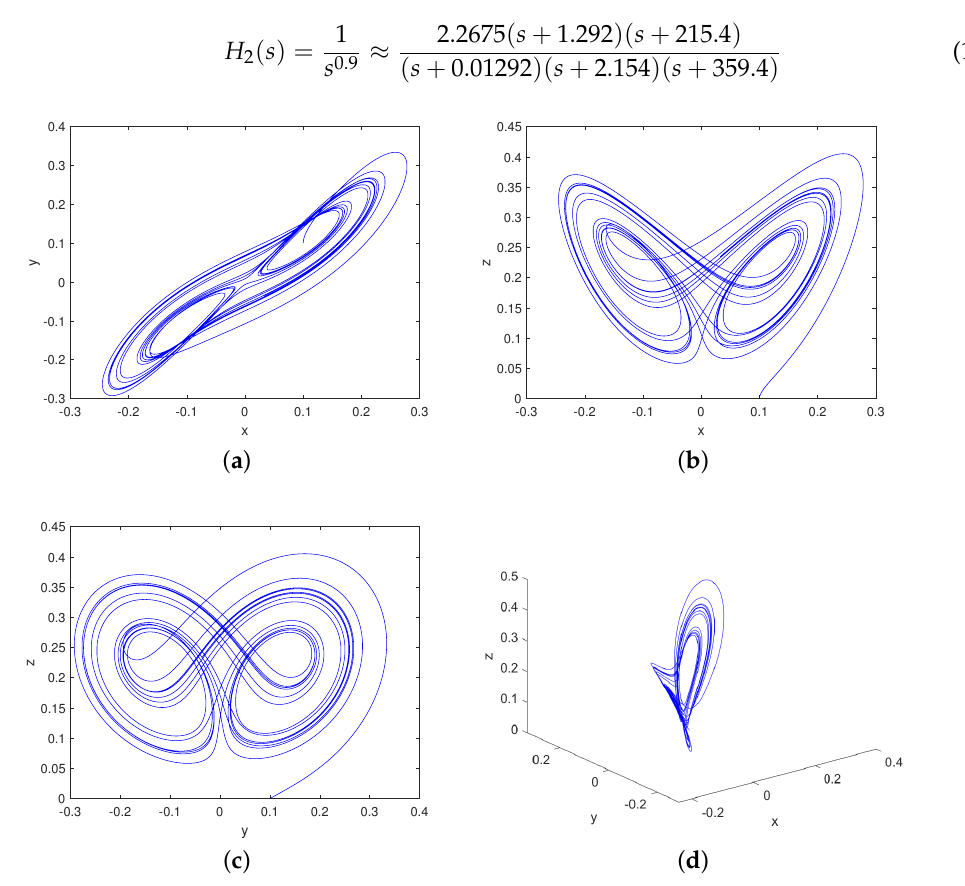
Figure 5. Portraits of the chaotic Chen system given in (10), by setting a = 0.35, b = 0.03, and c = 0.28, and using initial conditions x 0 = y 0 = z 0 = 0.1. ( a ) x-y, ( b ) x-z, ( c ) y-z, and ( d ) x-y-z planes.